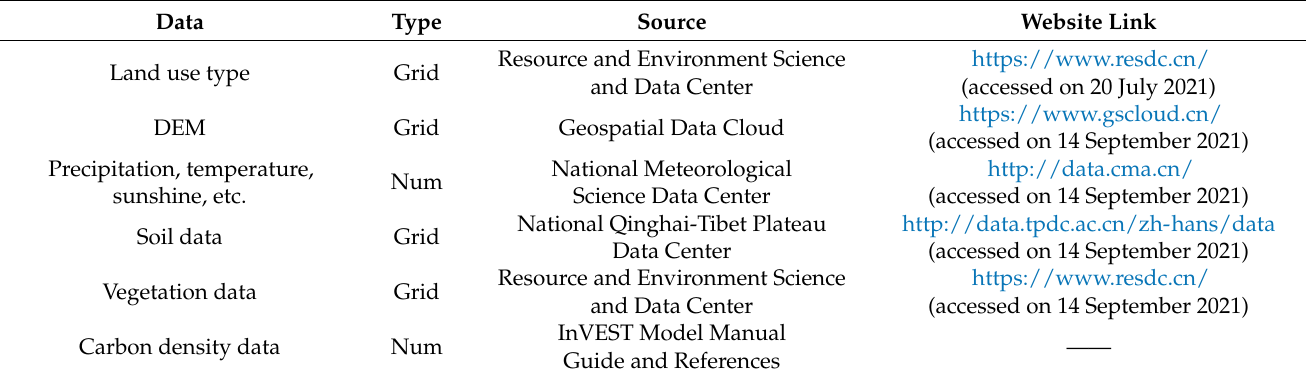
Table 1. Data and